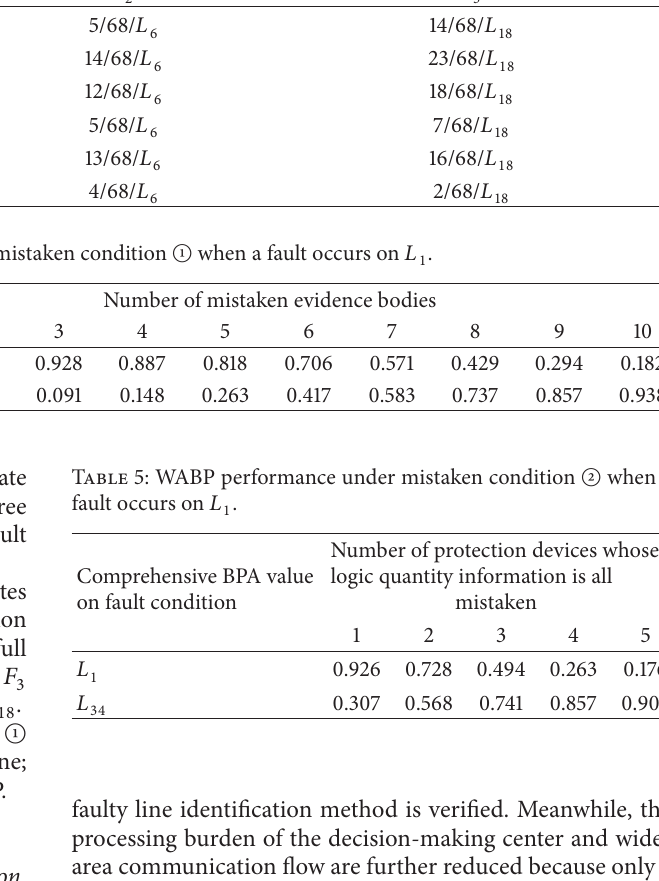
Table 3: The number of uploaded amplitudes of sequence fault currents and identified suspicious faulty line. Fault types